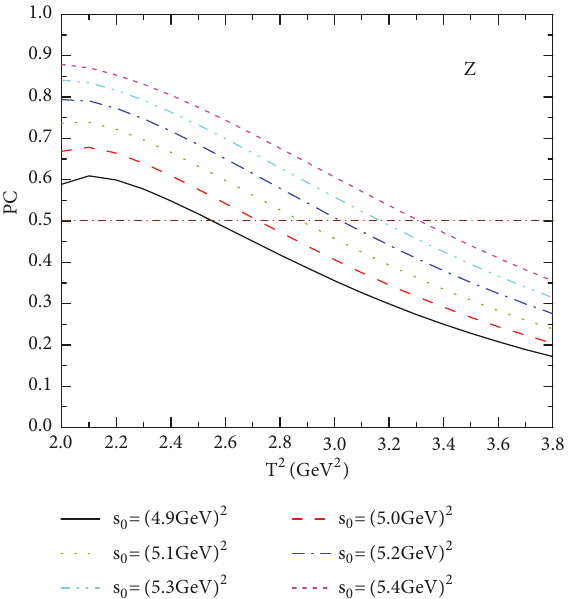
Figure 1: The pole contribution with variation of the Borel param- eter 𝑇 2 .